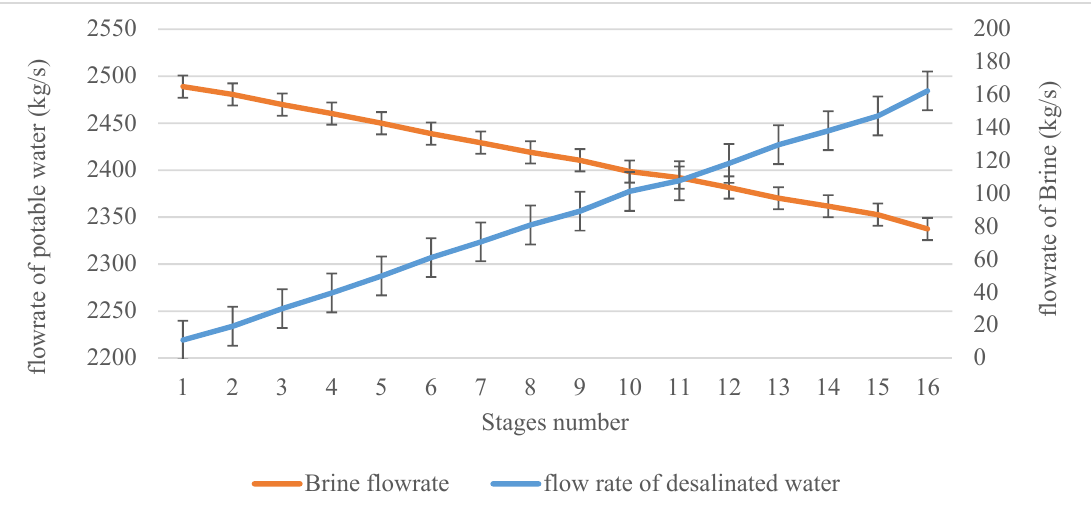
Figure 10. Mass flow rates of brine water (feed water) and desalinated water in the demisters. To illustrate the strengths of MSF in terms of desalinated water generation, it can be compared with the performance of RO and MED, which are the main technologies governing the desalination domain. Al Adwani et al. [23] studied the sensitivity and the effect of different operating parameters on the performance of RO desalination plants. The effect of seawater flow rate was one of the examined parameters that are directly related to the results of this research in terms of distillate water and brine flow rates. They found that increasing the mass flow rate of feed water (water intake) caused a slight increase in brine, which makes sense, while increasing the flow rate of feed water was accompanied by a significant decrease in water recovery (desalinated water). They stated that when increasing the mass flow of feed water from 0.001 m 3 /s to 0.005 m 3 /s, water recovery decreased by around 62%. As can be seen in Figure 11, increasing the feed flow rate simply means a lower residence time of the fluid inside the membrane module, which would significantly reduce the filtration time and cause a reduction in water flux.